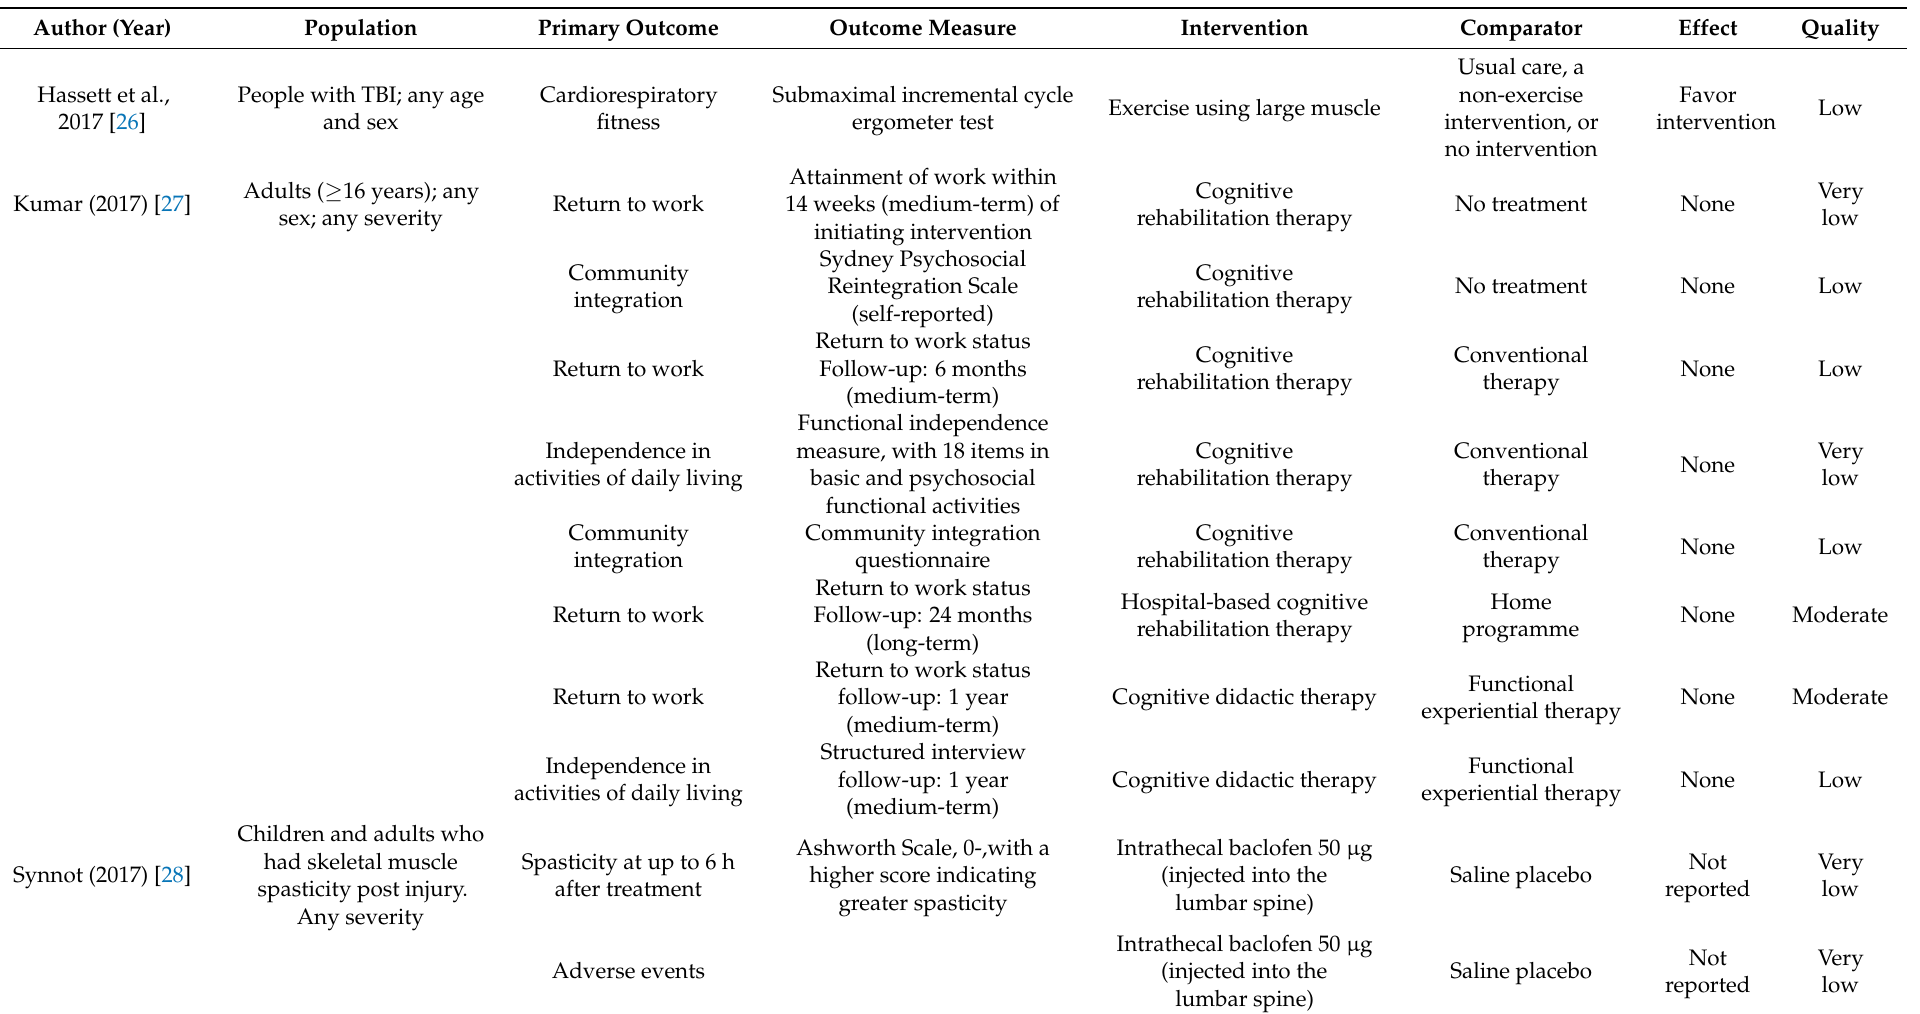
Table 1. Characteristics of included systematic